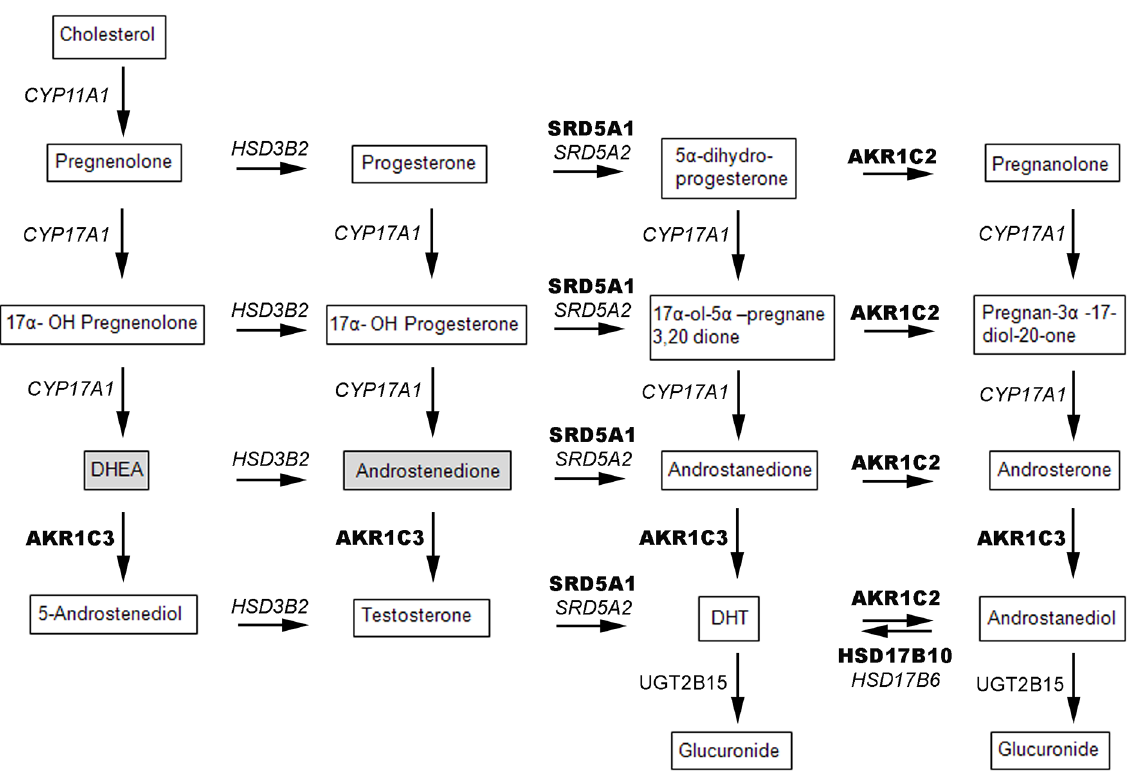
Figure 1. Simplified scheme of the key steps of testosterone and DHT steroidogenesis. Enzymes with significantly higher mRNA levels observed in bone metastases than in non-malignant and/or malignant prostate tissue are shown in bold and enzymes with significantly lower levels observed in bone metastases are shown in italics . Steroids secreted by the adrenal gland are highlighted in gray.